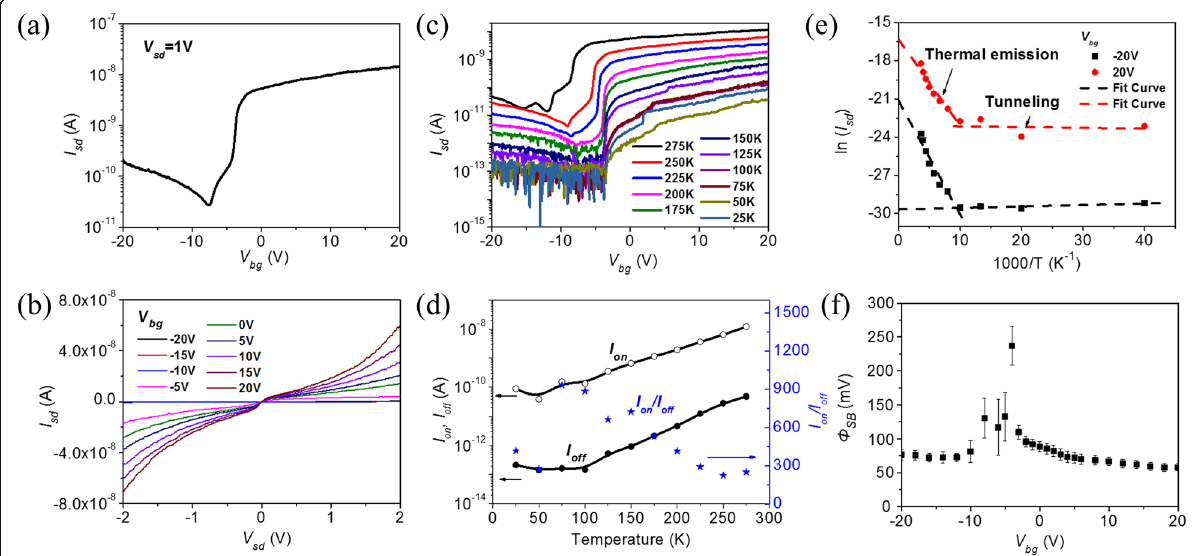
Fig. 6 N-type multi-layered MoTe 2 transistor properties in vacuum. a RT transfer characteristics of MoTe 2 transistor at V sd = 1 V. b RT output characteristics of MoTe 2 transistor at different back-gate voltage. c Transfer characteristics of MoTe 2 transistor as a function of temperature. d On-current, off-current, and on-off current ratio of MoTe 2 transistor as a function of temperature. e Arrhenius plot of the I V V − 20 V and 20 V, respectively. f Maps of effective Schottky barrier heights Φ sd at sd = 1 V and bg =